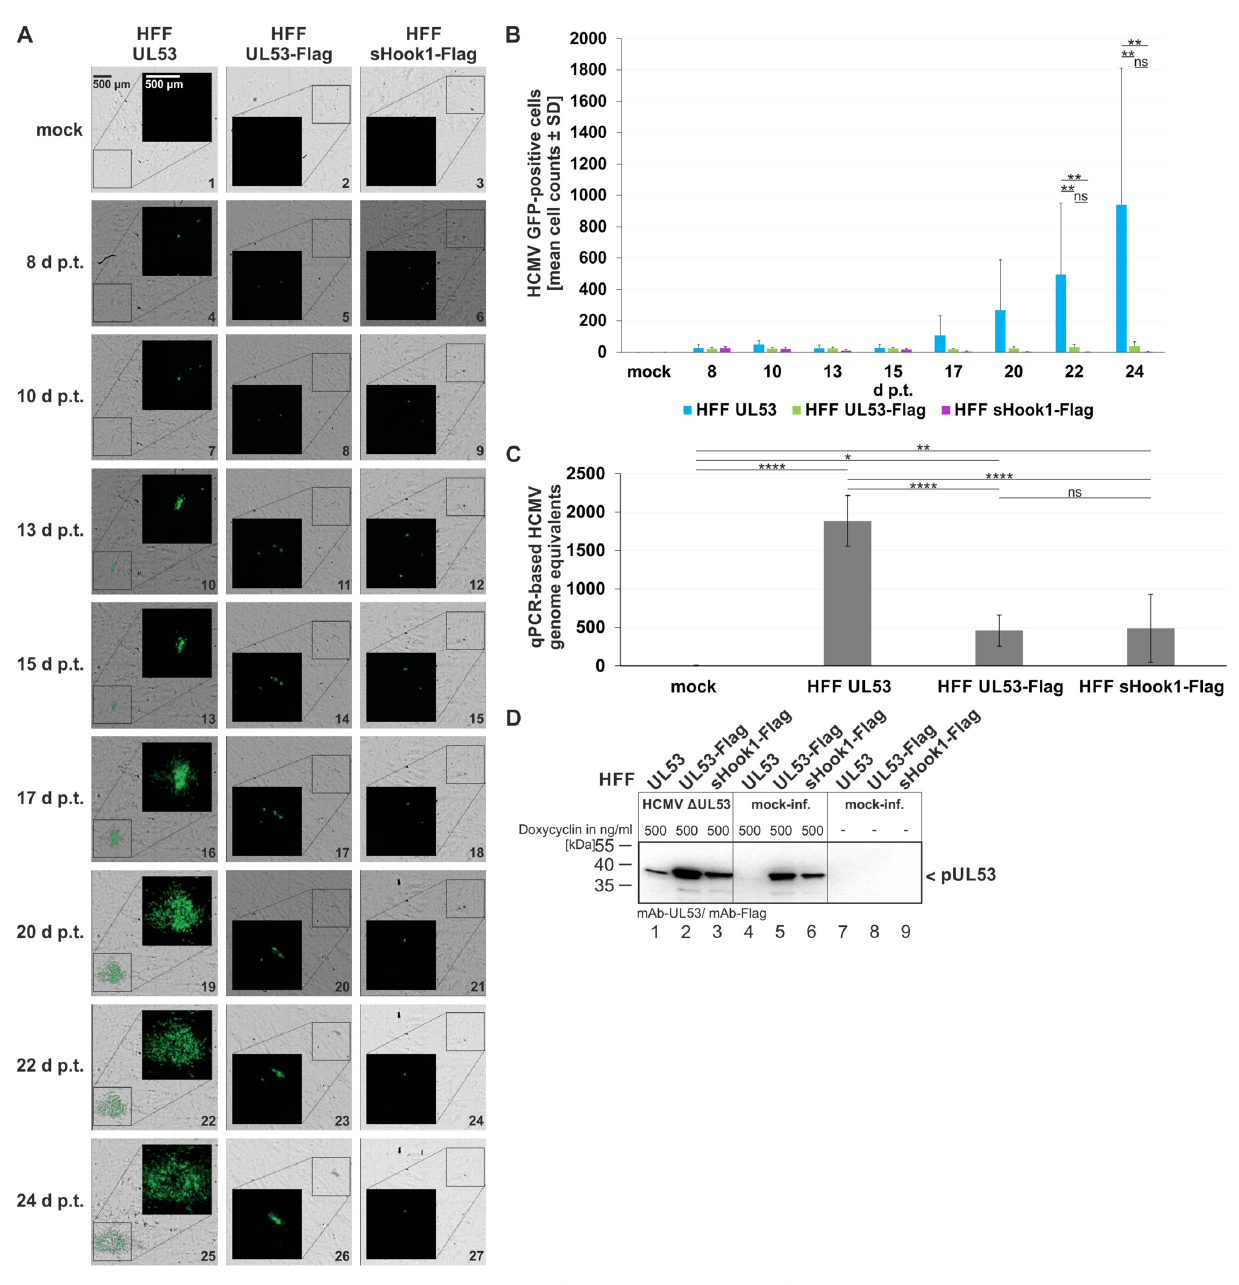
Figure 12. Qualitative and quantitative analyses of HCMV AD169 ‐ GFP Δ UL53 virus reconstitution on the different recombinant HFF cell populations. HFFs that express pUL53, pUL53 ‐ Flag or pUL53::sHook1 ‐ Flag were transfected with the infectious bacterial artificial chromosome of HCMV Δ UL53. ( A ) Images of the GFP signals and the respective brightfield illuminations were taken at indicated time points; scale bar in panel A, picture 1 marks 500 μ m. ( B ) Quantitative analysis of fluorescence ‐ positive cells was achieved with automated counting by the CellReporterXpress ® software (Molecular Devices LLC, San Jose, CA, USA). Counting parameters for positive nuclei were set to an intensity of at least 100, a minimal width of 7 and a maximal width of 30. Measurements were performed in biological sextuplicates per cell population of 5.05% area of the well and mean values ± SD are given. ( C ) qPCR ‐ based assay for the determination of viral genome equivalents referring to the respective recombinant HFF populations. Viral supernatants were harvested at day 24 p.t. and subjected to IE1 ‐ specific qPCR. Calculations were performed in biological sextuplicates